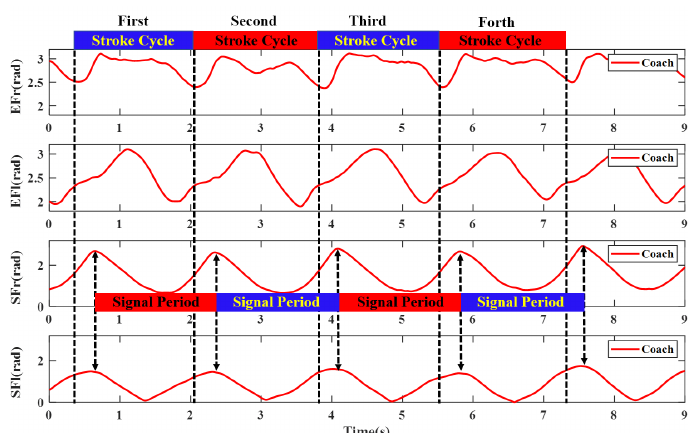
Figure 11. The elbow and shoulder flexion joint angle of coach.